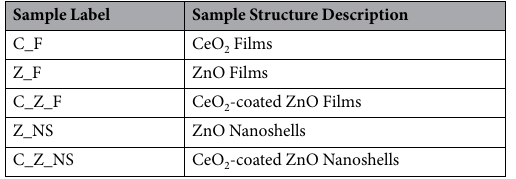
Table 1. Associated labels for sample structures used in this study.